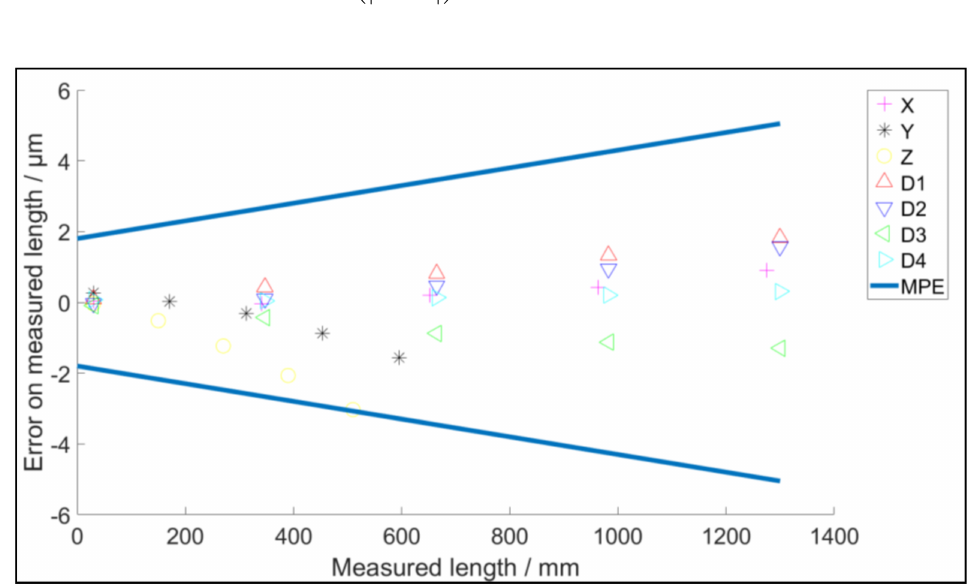
Figure 5. ISO 10360 − 2 test for the virtual